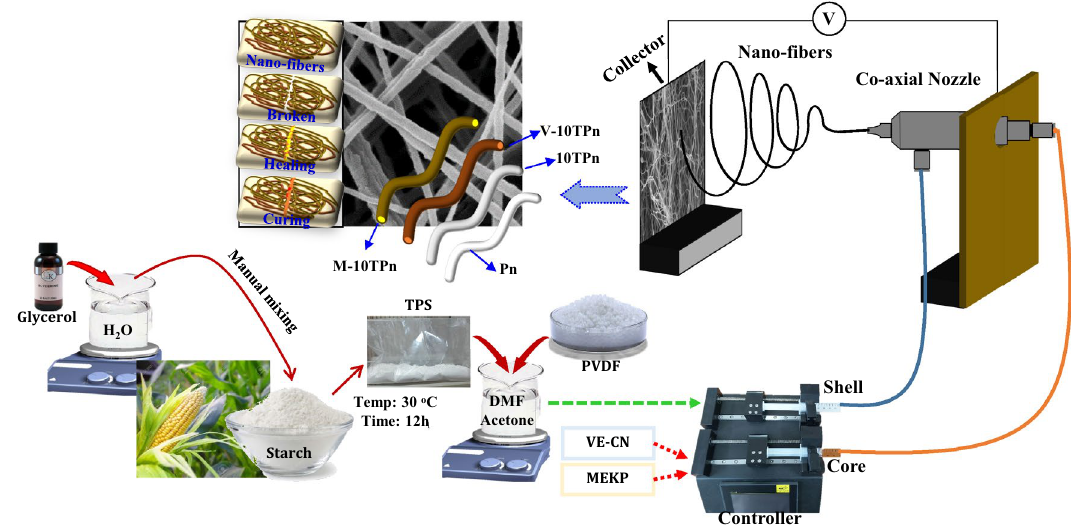
Figure 1. Schematic representation of electrospinning process producing TPS/PVDF core–shell